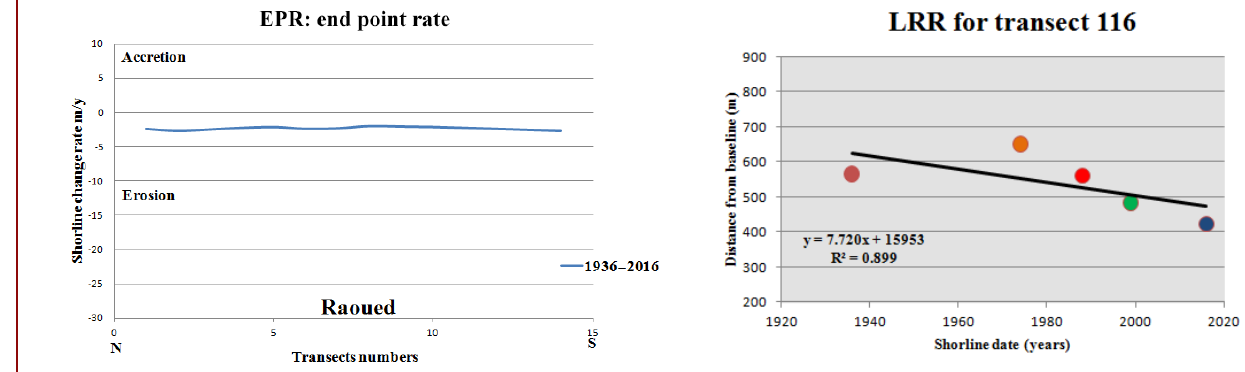
Figure 13. Linear regression of transect